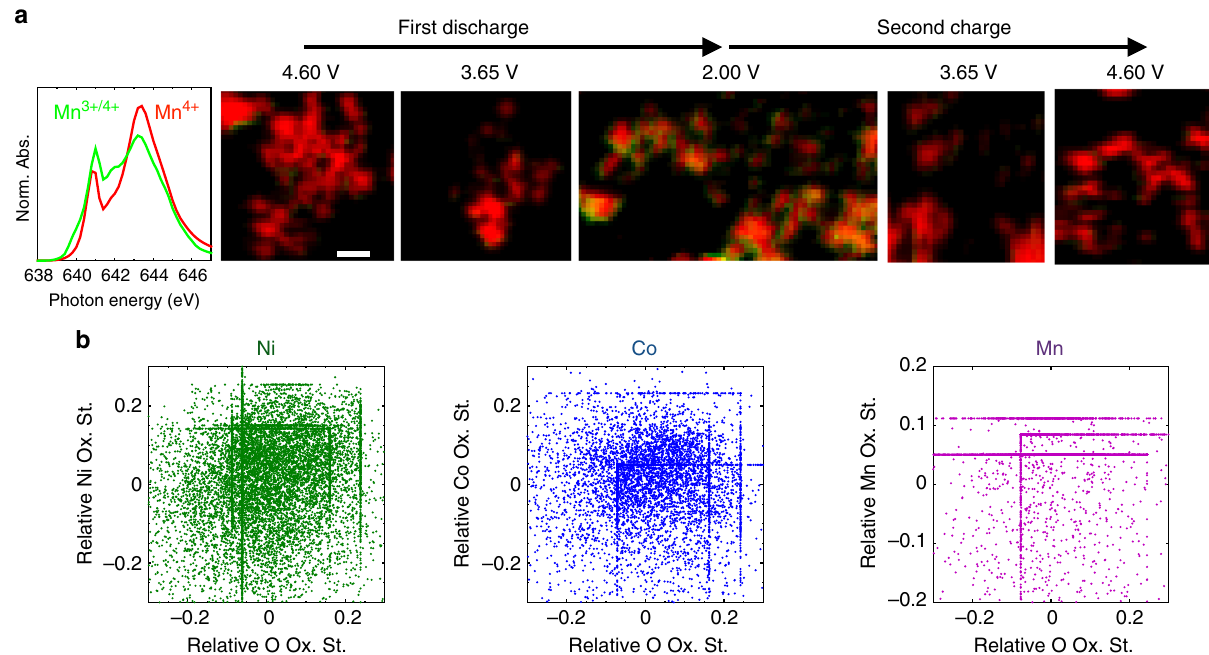
Fig. 4 Spatial separation of O oxidation and TM reduction. a Maps of the two Mn end-member spectra (left) obtained by NMF throughout the fi rst discharge and second charge, showing the reversible reduction of Mn only at the particle surfaces upon discharge to 2.00 V. The Mn oxidation states are assigned based on previous literature 88 . Scale bar is 500 nm. b Scatter plots of the single-pixel O oxidation state (i.e. fraction of the fully oxidized O phase) vs. the TM oxidation state (i.e., fraction of TM 4+ ) throughout the fi rst charge voltage plateau, showing minimal correlation between the O and TM oxidation states during O oxidation. The single-pixel TM and O oxidation states for each sample along the plateau are plotted relative to their respective means for each sample to generate the plots. The means for each sample at each edge can be seen in Fig. 2b and Supplementary Fig. 4a. The straight lines are due to pixels with 100% or 0% of a given oxidation state, shifted by the mean of the sample to which those pixels